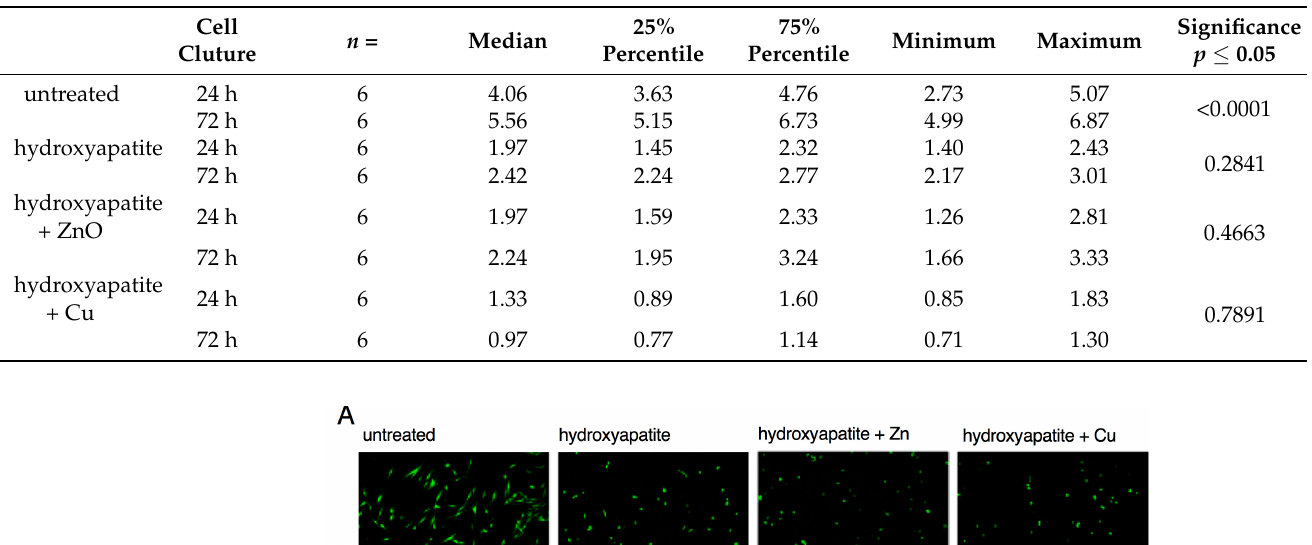
Table 4. Descriptive analysis (median, percentiles, minimum, and maximum) of HGF-1 green value after 24 h and 72 h of cell cultivation measured in arbitrary units. Significant differences in the results after 24 h and 72 h are highlighted in grey.